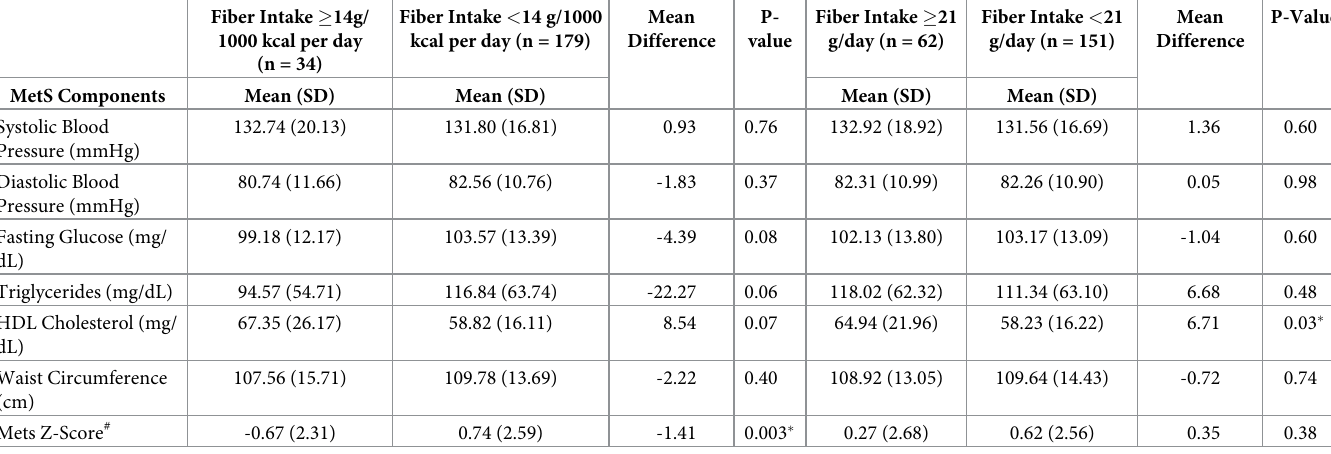
Table 2. Differences in MetS components by daily fiber recommendations per 1000kcal and daily total fiber